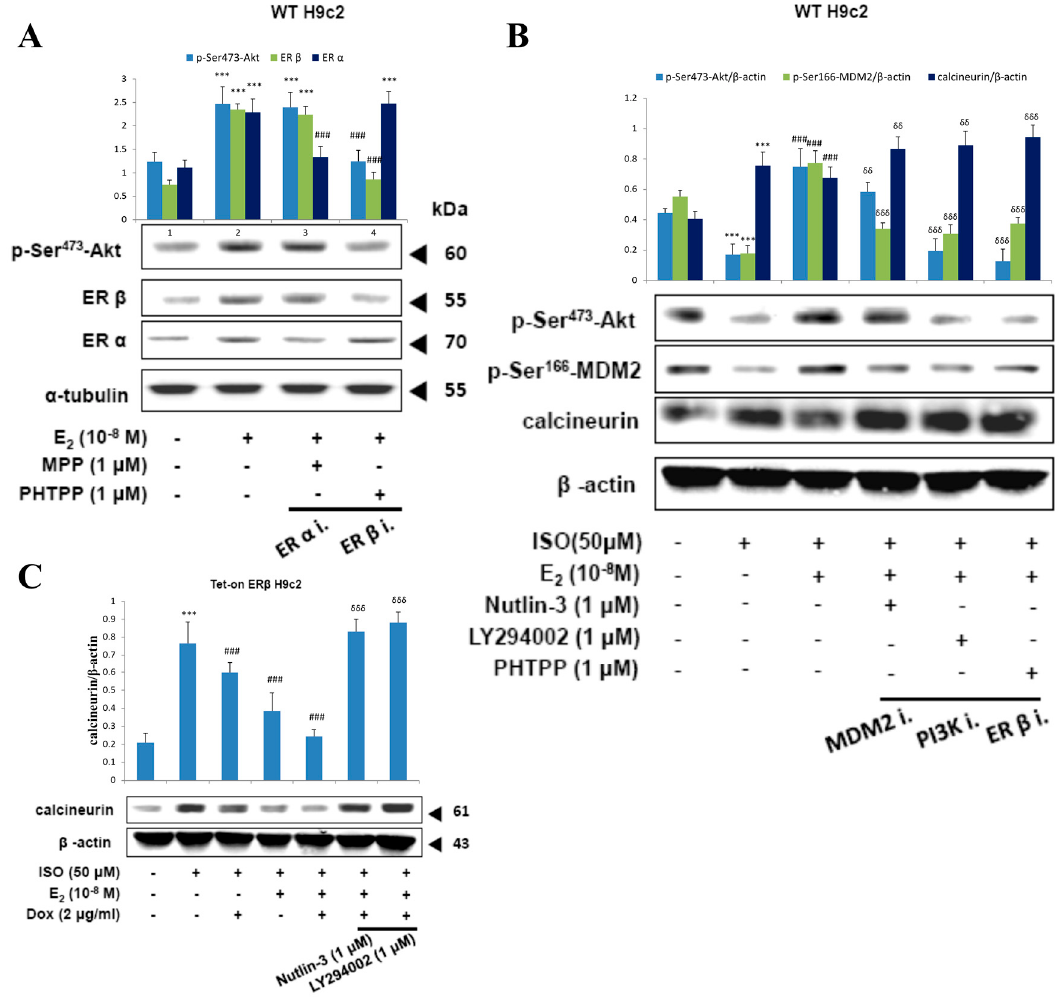
Figure 6. E2/ER β enhances calcineurin protein degradation via PI3K/Akt/MDM2 signaling. ( A ), H9c2 cells were incubated with MPP (1 μ M), PHTPP (1 μ M) in the presence of E2 (10 − 8 M) for 24 h, then western blotting was performed. p -Akt (Ser473), ER α , ER β , and α -tubulin were detected by western blot. ( B ), H9c2 cells were incubated with E2 (10 − 8 M), MDM2 inhibitor Nutlin-3 (1 μ M), PI3K inhibitor LY294002 (1 µ M), PHTPP (1 µ M) in the presence of ISO (50 µ M) for 24 h, then western blotting was performed. p -Akt (Ser473), p -MDM2 (Ser166), calcineurin and β -actin were detected by Western blot. ( C ), Tet-on ER β H9c2 cells were incubated with E2 (10 − 8 M), Dox (2 µ g/mL), Nutlin-3 (1 µ M), LY294002 (1 µ M) in the presence of ISO (50 µ M) for 24 h, then western blotting was performed. Calcineurin and β -actin were detected by Western blot. (*** = p < 0.001indicates significant difference with respect to the Control group; ### = p < 0.001 indicates significant difference with respect to the ISO challenged group, δδ = p < 0.01 and δδδ = p < 0.001 indicate significant differences with respect to the E2 treated group).